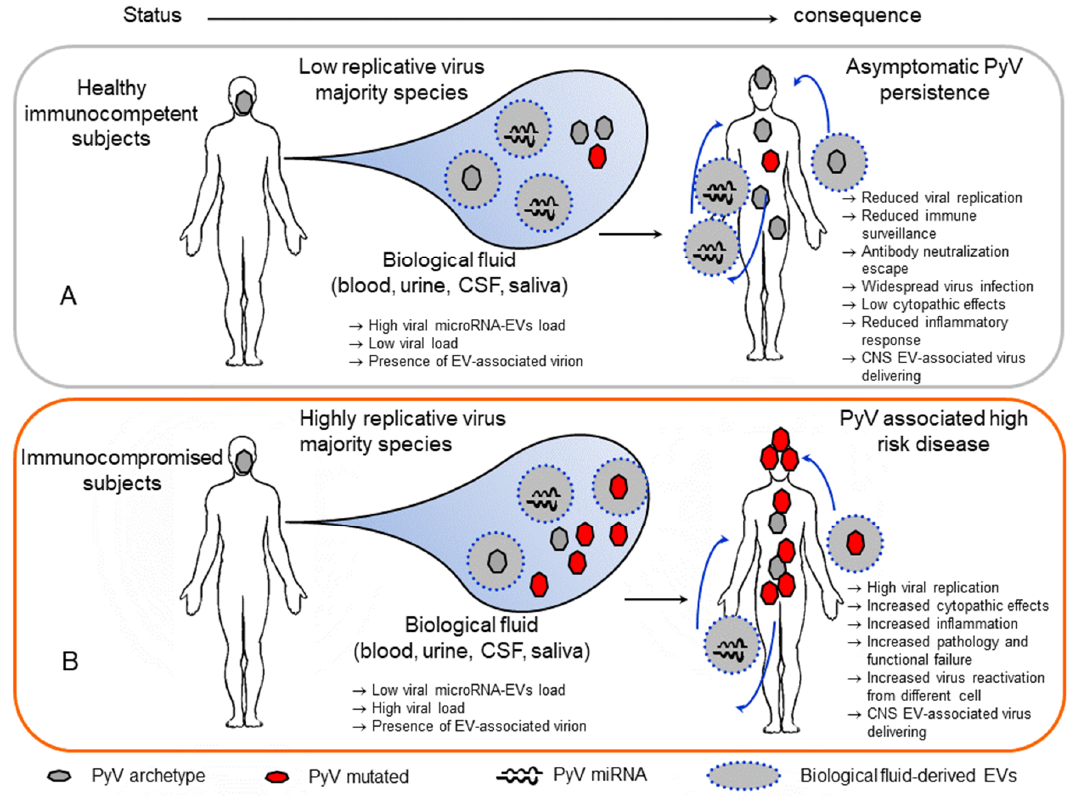
Figure 2. Potential role of extracellular vesicles in polyomavirus infection. ( A ) In healthy immunocompetent subjects, polyomaviruses persist in di ff erent tissues. In these subjects, replication